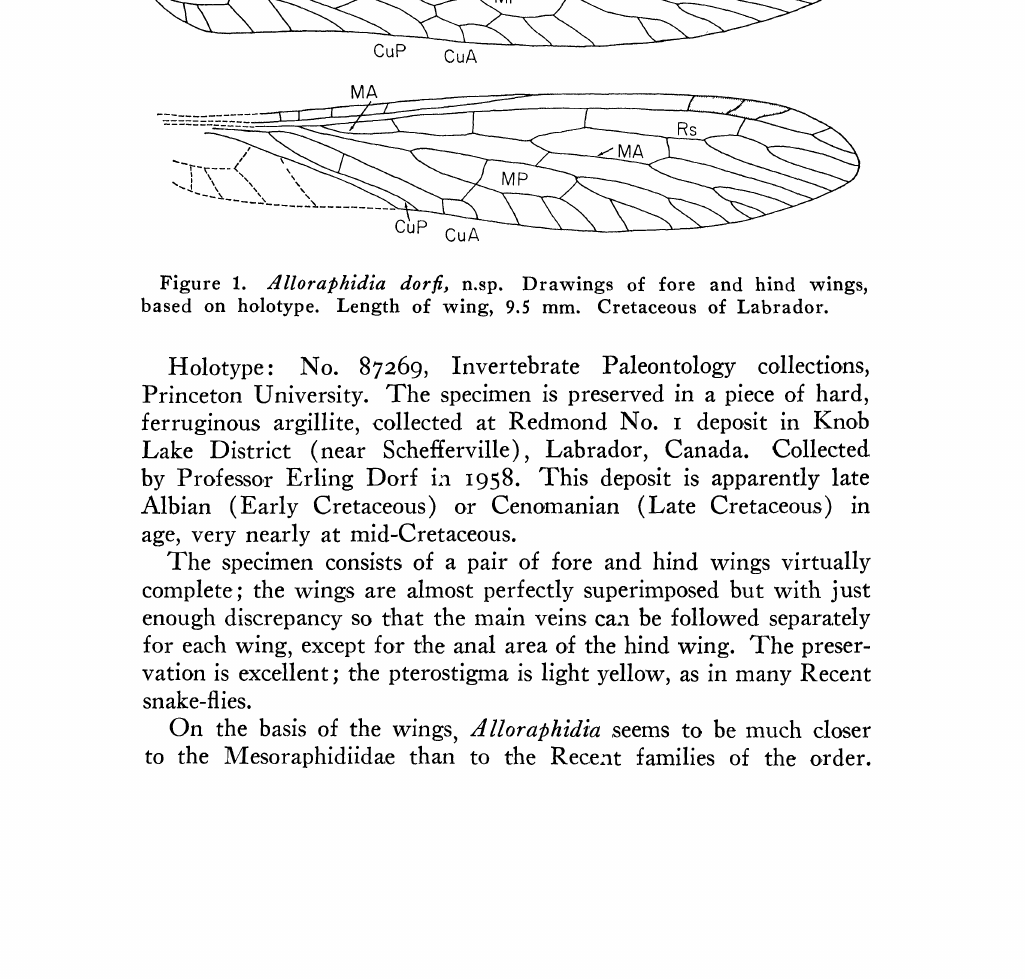
Figure 1. Alloraphidia dorfl, n.sp. Drawings of fore and hind wings, based on holotype. Length of wing, 9.5 mm. Cretaceous of Labrador. Holotype: